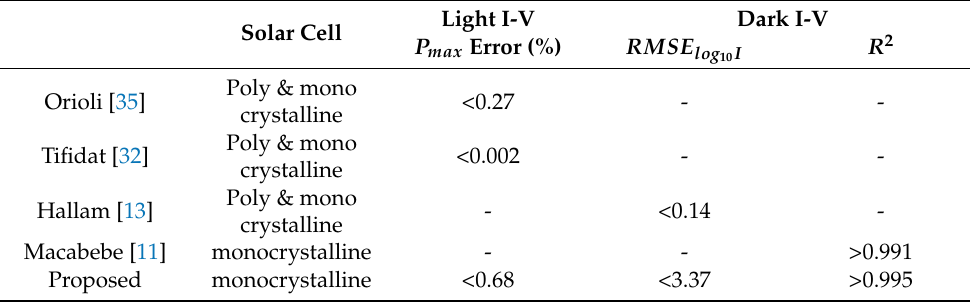
Table 5. Comparison with other parameter extraction